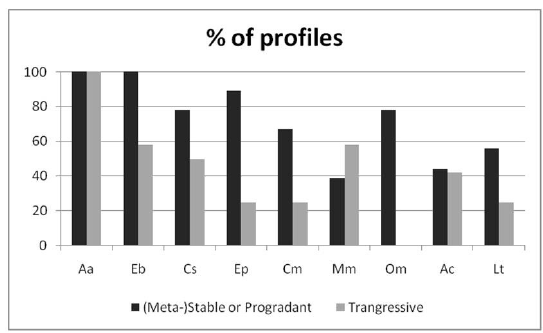
Figure 5. Occurrence of the nine most frequent taxa in the data- set, computed as the percentage of profiles of each major profile type (S and T) in which each species was recorded. Notice how the general tendency of species to occur preferably in (meta-) stable/progradant profiles is clearly enhanced in the case of Eu- phorbia paralias (Ep), Crucianella maritima (Cm) and Otanthus maritimus (Om). Plant taxa (see Appendix 1 for codes) are or- dered, from left to right, according to their global frequency in the